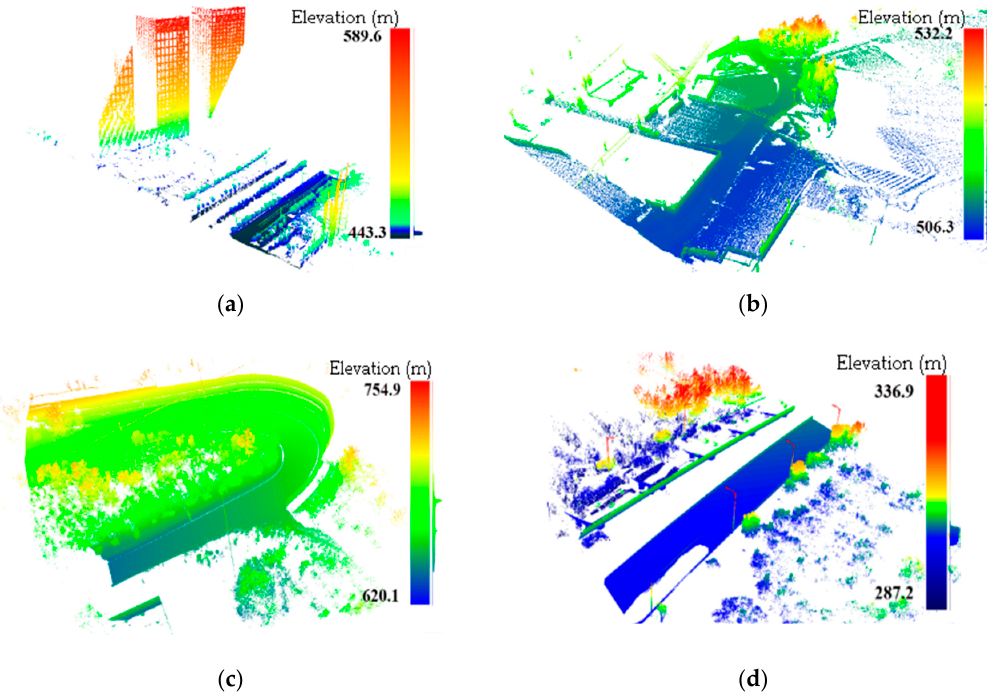
Figure 11. Test data for four typical environments rendered with point elevation. ( a ) Data 1. ( b ) Data 2. ( c ) Data 3. ( d ) Data 4.